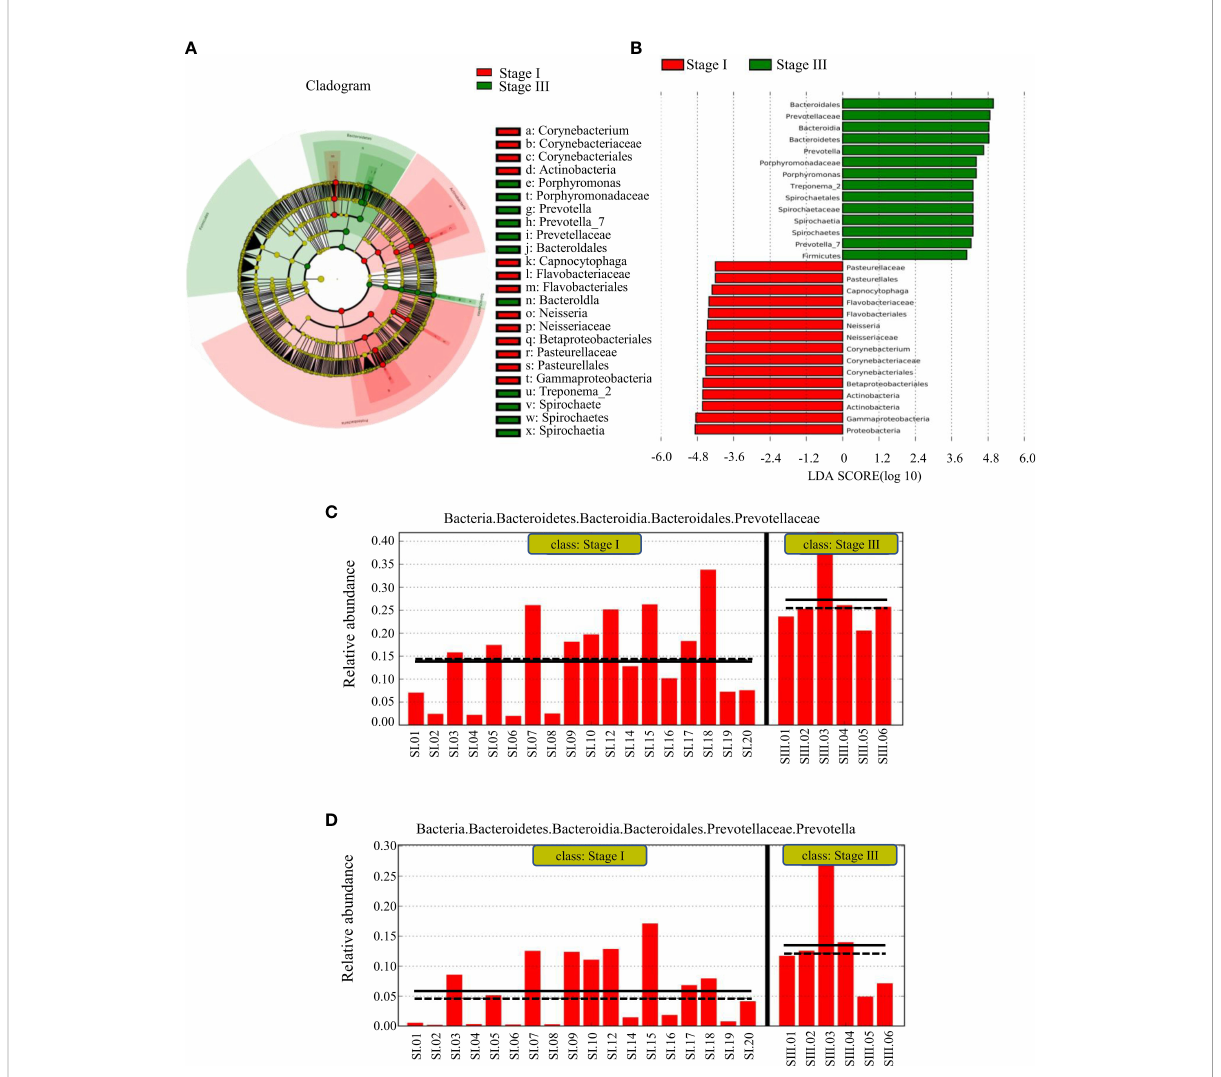
FIGURE 4 LEfSe results on the oral microbiome in different groups. (A) Histogram of the LDA scores between women with stage-I or stage-III periodontitis. Samples from women with stage-I periodontitis enriched taxa are indicated with a positive LDA score (green), and taxa enriched in samples from women with stage-III periodontitis have a negative score (red). The threshold on the logarithmic LDA score for discriminative features was set to 3.0. (B) Taxonomic cladogram obtained from LEfSe. The cladogram reports the taxa (highlighted by small circles and by shading; red indicating samples of stage-I periodontitis, green indicating samples of stage-III periodontitis and yellow indicating a non- signi fi cant relationship) showing different abundance values. (C, D) represent predominant biomarkers in patients with stage-III